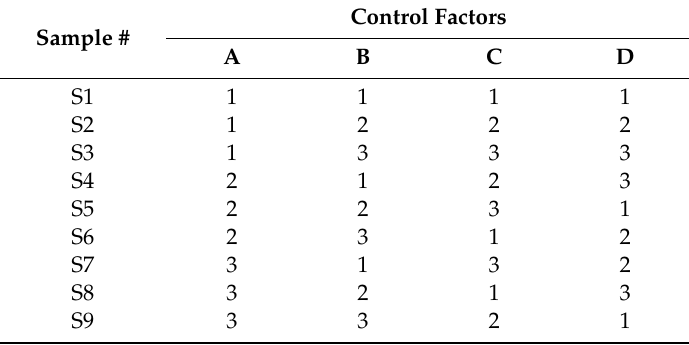
Table 2. Antimicrobial conditions of E. coli using the Taguchi L9 orthogonal array table. Symbols and numbers of control factors reflect the parameters and levels in Table 1.